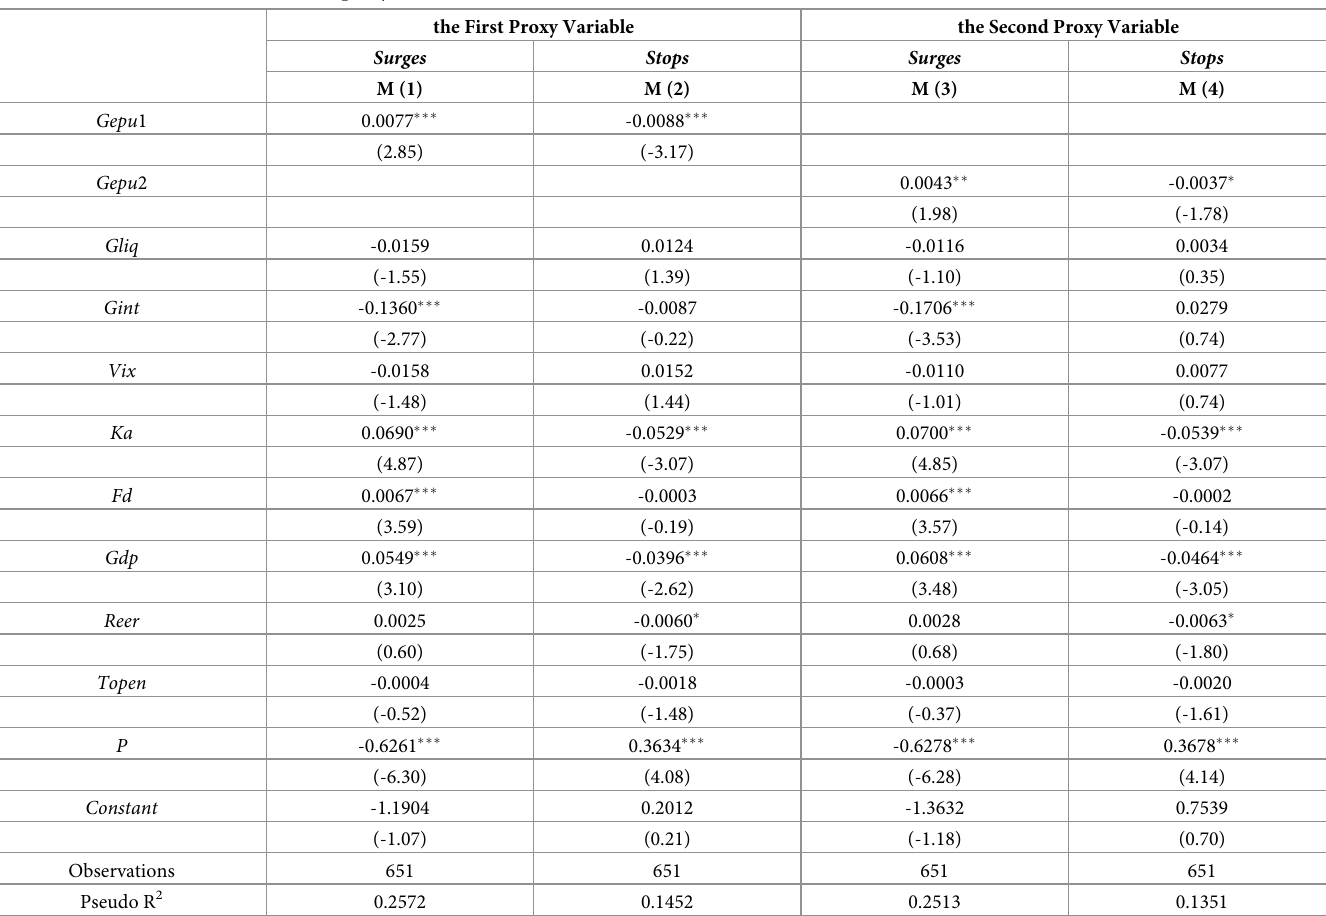
Table 9. Robustness test results of another proxy